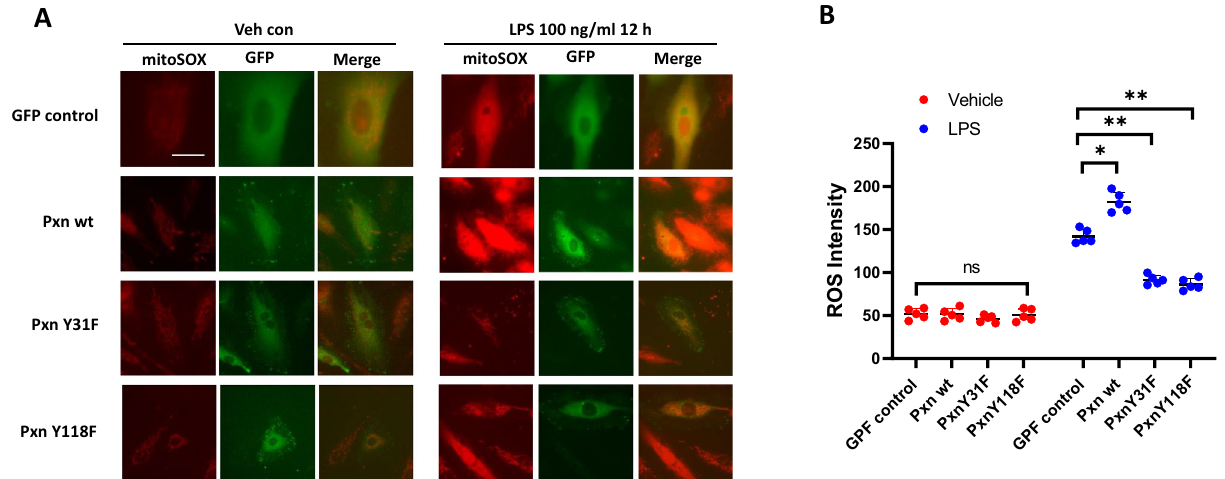
Figure 2. Paxillin mediates LPS-induced mitochondrial ROS. ( A ) HLMVECs were transfected with GFP- tagged control plasmid, wild type paxillin, paxillinY31F, or paxillin Y118F mutant plasmids before LPS treatment. Mitochondrial ROS were detected by MitoSOX dye. At least 20 GFP positive cells were selected for imaging. Images are representative of 5 independent experiments. Scale bar: 5 μm. ( B ) ROS were quantified by measurement of fluorescence intensity by Image J software. Data were presented as mean ± SD, *p < 0.05, LPS Pxn wt versus LPS control plasmid; **p < 0.01, LPS PxnY31F or LPS PxnY118 versus LPS control